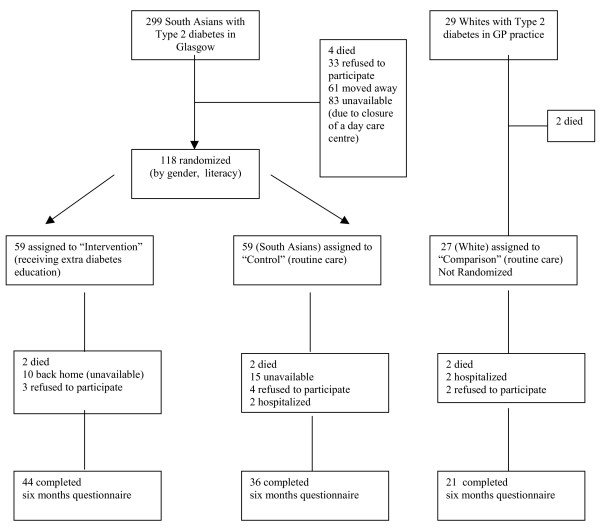
Outline the flow of patients from baseline to 6-month follow up.